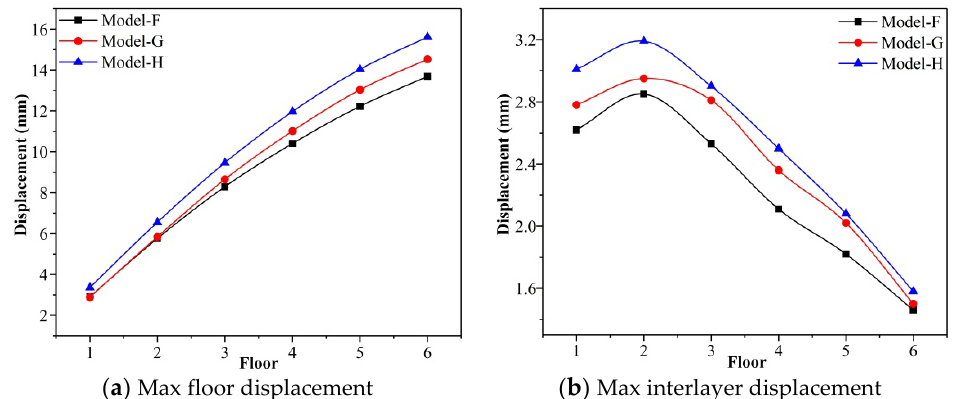
Figure 19. The floor displacement and interlayer displacement in the Y-direction.